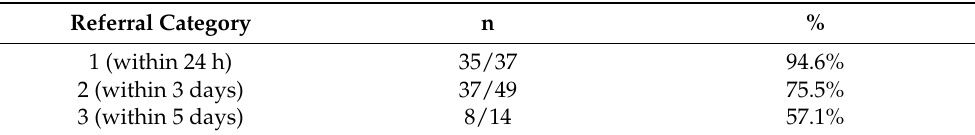
Table 3. No. of participants responded to within timeframe of their referral category (n = 100).